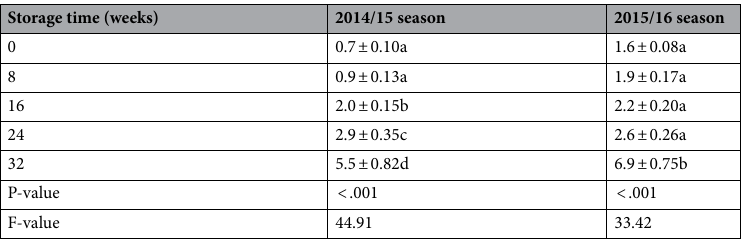
Table 6. Overall time effects on sorghum grain weight loss during the 2014/15 and 2015/16 storage season in Mbire district, Zimbabwe (n = 56). Means are compared per column, and those which do not share the same letter are significantly different from one another using Fishers Protected LSD test at 0.05 level.